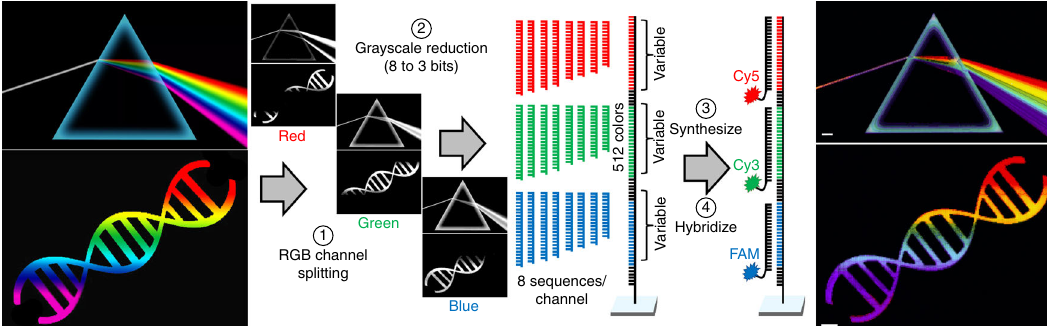
Fig. 2 Large-scale nucleic acid photolithography (Level-One patterning). Rendering in DNA of a color image. Original RGB is split into individual color channels, each of which is reduced to 8 shades of gray. Each shade of each color channel is assigned a DNA sequence with a calibrated melting temperature with a fl uorescently-labeled complementary oligonucleotide. A sequence for each pixel is constructed with one of the resulting 512 variants. After photolithographic synthesis of all the DNA sequences, the surface is hybridized with the three complementary or partially complementary Cy3-, Cy5- or fl uorescein-labeled oligonucleotides. The scale bars in the resulting fl uorescence images are 200 µ